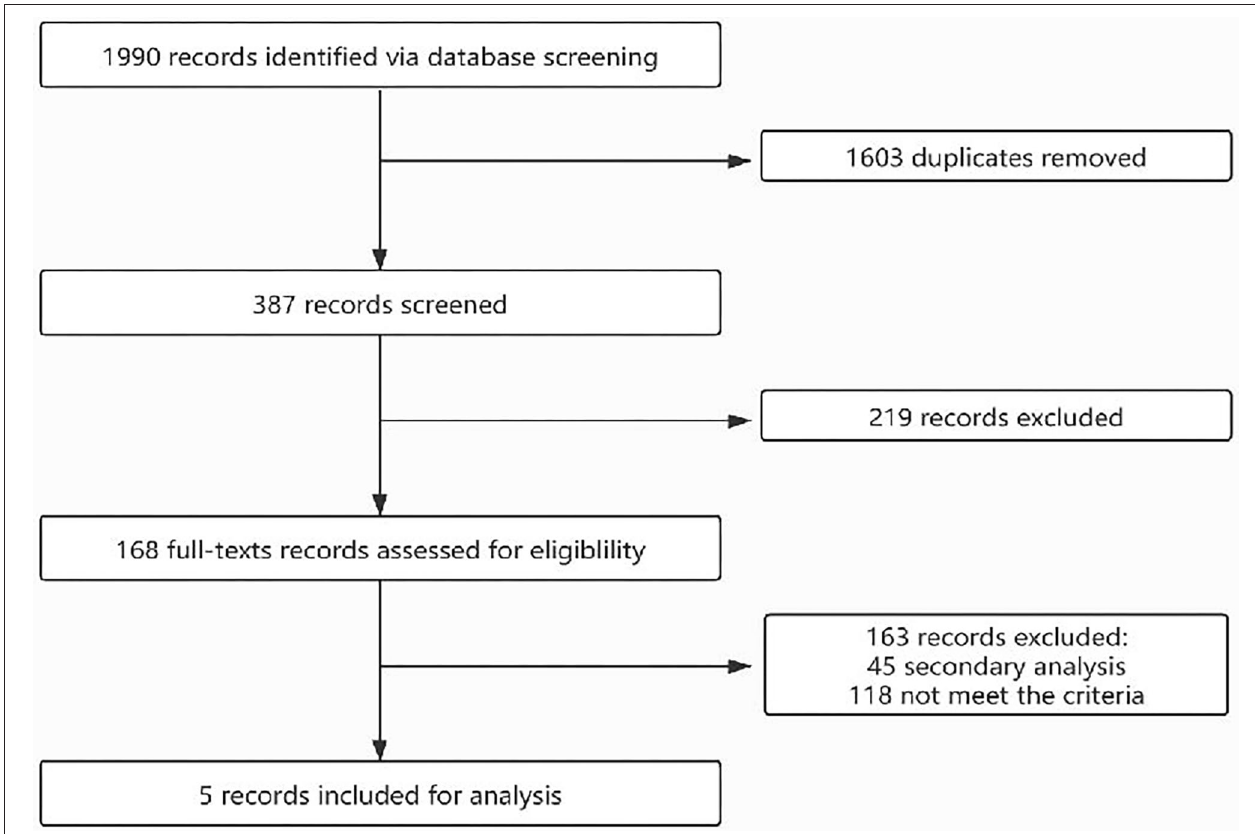
FIGURE 1 | The flow of the selection